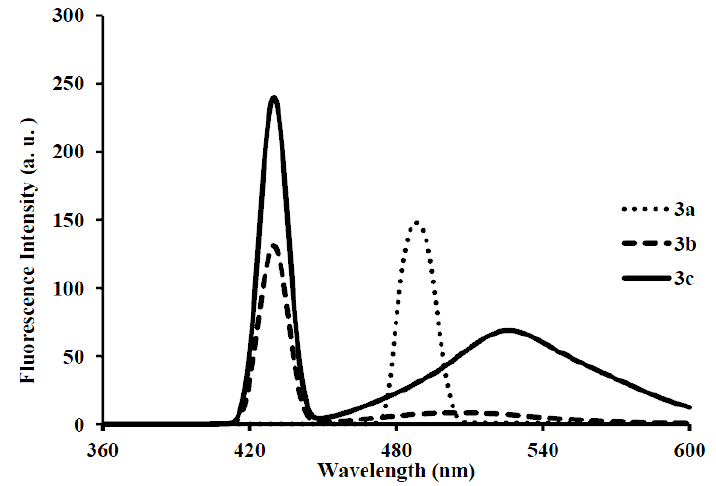
Figure 11. The fluorescence emission spectra of 3a – c ( λ (1:1, v/v) (conc. 2.0 × 10 − 7 mol/L) at rt.